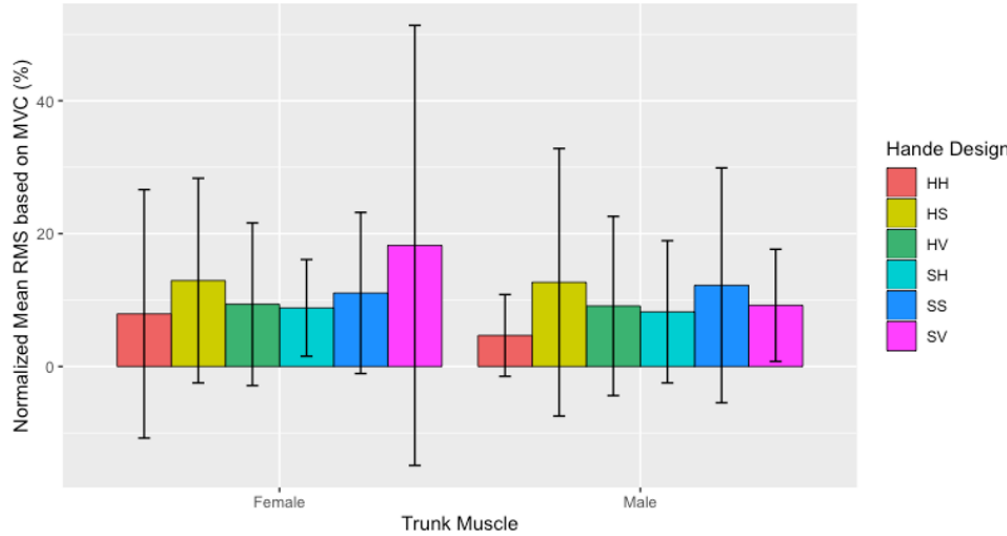
Figure 8. Normalized mean RMS (mean ± SD) based on the percentage (%) across all trunk muscles separated by biological sex between handle designs at the initiation of the push.